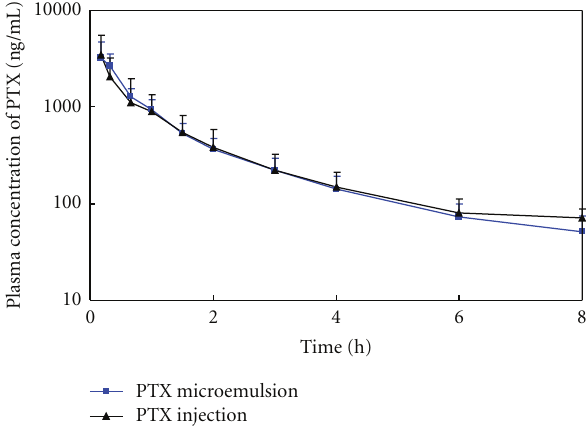
Figure 2: The plasma concentration-time profiles of PTX after intravenous administration of PTX microemulsion or PTX injec- tion at 5mg/kg PTX in SD rats (means ± S.D., n = 5).